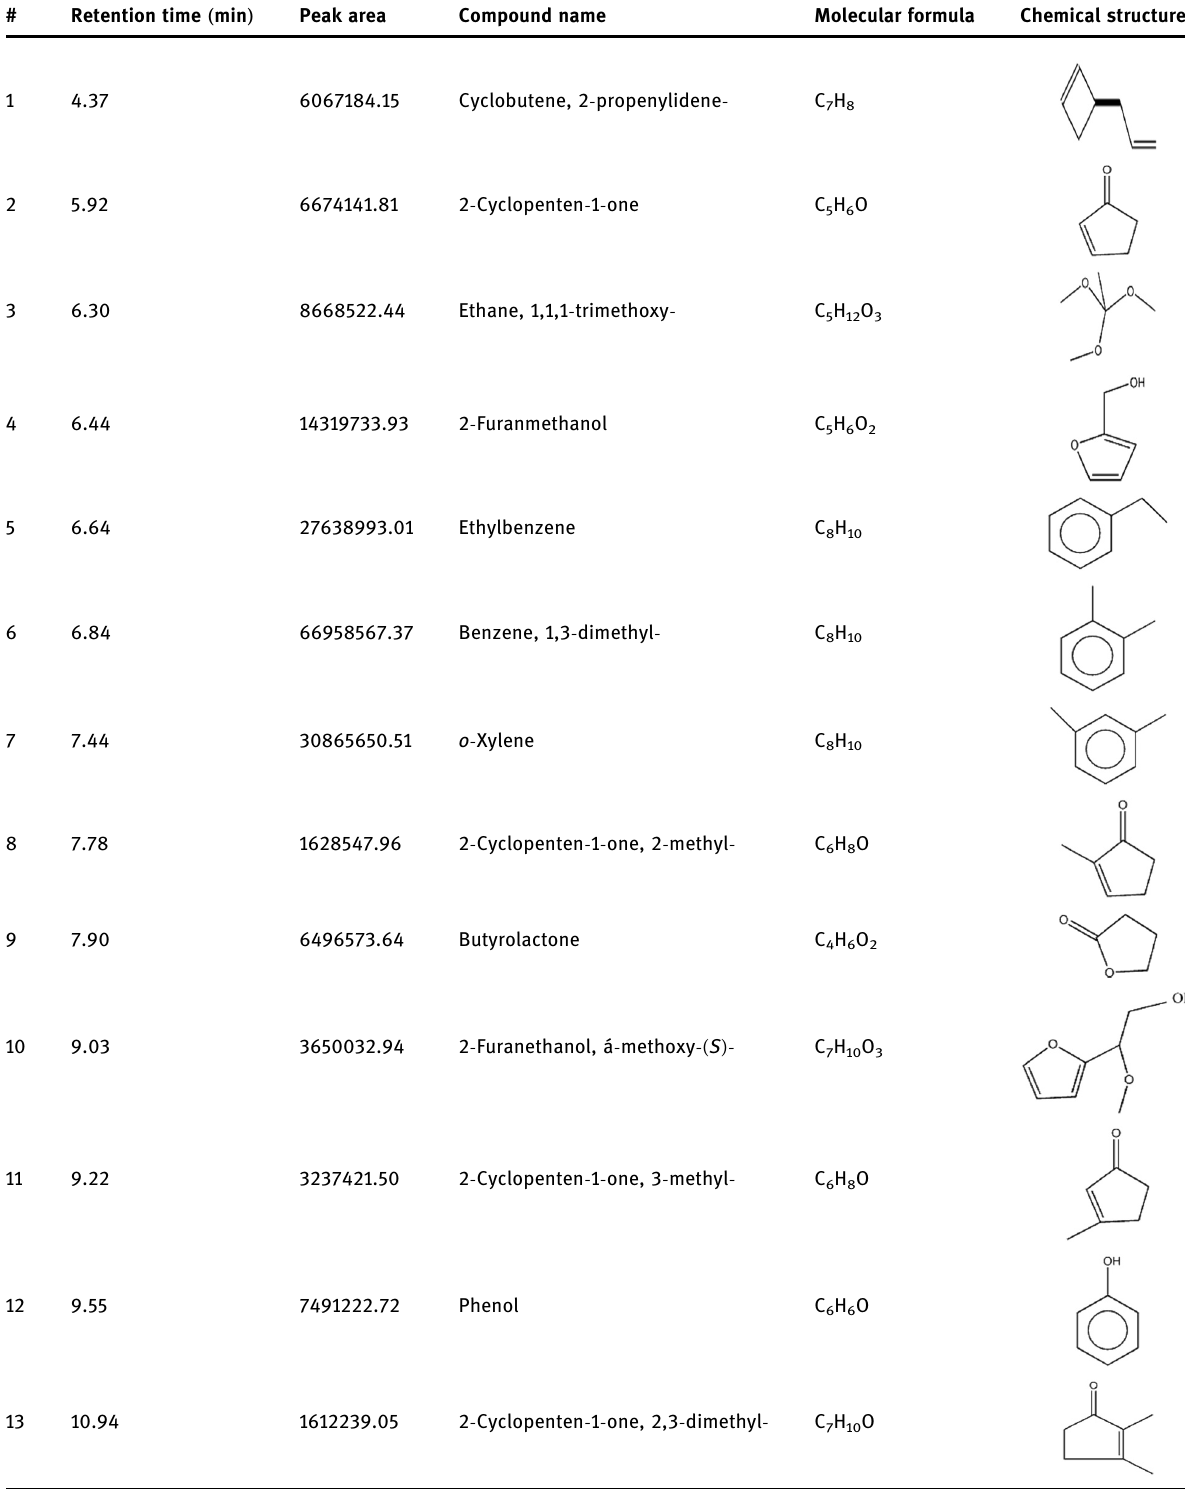
Table 4: Bio - oil main components identi fi ed by GC - MS in CaO